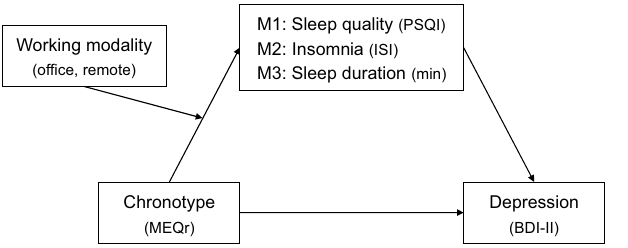
Figure 1. The three theoretical moderated mediation models tested (M1, M2, M3). Three mediators (sleep quality, insomnia symptoms, sleep duration) are hypothesized to mediate the relationship between morningness-eveningness continuum and severity of depression symptoms in a context where working modality (office working, remote working) moderate the effect of chronotype on sleep variables. Each model was adjusted for age and gender. Abbreviations: PSQI, Pittsburgh Sleep Quality Index; ISI, Insomnia Severity Index; MEQr, Morningness-Eveningness Questionnaire-reduced version; BDI-II, Beck Depression Inventory- second